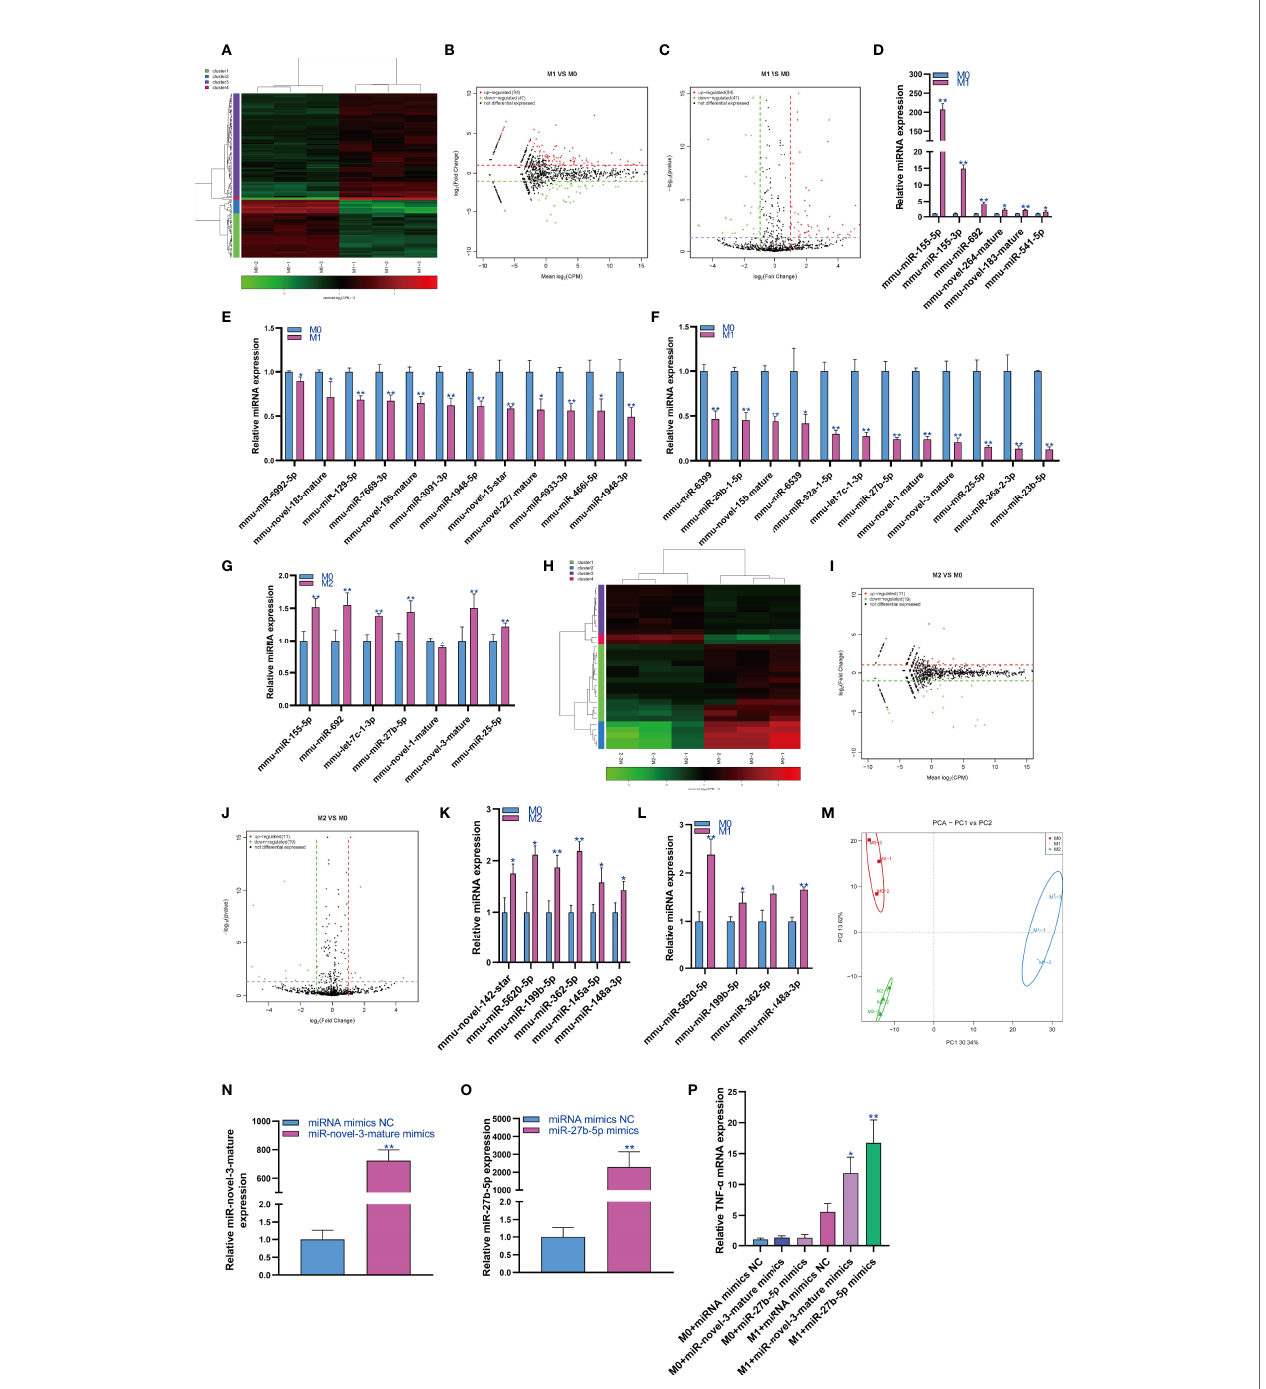
FIGURE 1 | Changes in miRNA expression during macrophage polarization. Hotmap (A) , MA (B) and volcano plot (C) show the small RNA sequencing results of the expression of miRNA in M0 and M1 macrophages. (D) The expression of miRNAs upregulated in M1 macrophages detected by qPCR. (E, F) The expression of miRNAs downregulated in M1 macrophages detected by qPCR. (G) The expression of miRNA in M2 macrophages detected by qPCR. Hotmap (H) , MA (I) and volcano plot (J) show the small RNA sequencing results of the expression of miRNA in M0 and M2 macrophages. (K) The expression of miRNA in M2 macrophages detected by qPCR. (L) The expression of miRNA in M1 macrophages detected by qPCR. (M) PCA of miRNA expression in M0, M1 and M2 macrophages. * indicates p < 0.05 compared to M0, and ** indicates p < 0.01 compared to M0. (N) The expression of miR-novel-3-mature in RAW264.7 cells transfected with miRNA mimics NC or miR-novel-3-mature mimics were detected by qPCR. (O) The expression of miR-27b-5p in RAW264.7 cells transfected with miRNA mimics NC or miR-27b-5p mimics were detected by qPCR. (P) The expression of TNF- a in RAW264.7 cells were detected by qPCR. * indicates p < 0.05 and ** indicates p < 0.01 compared to M1+ miRNA mimics NC